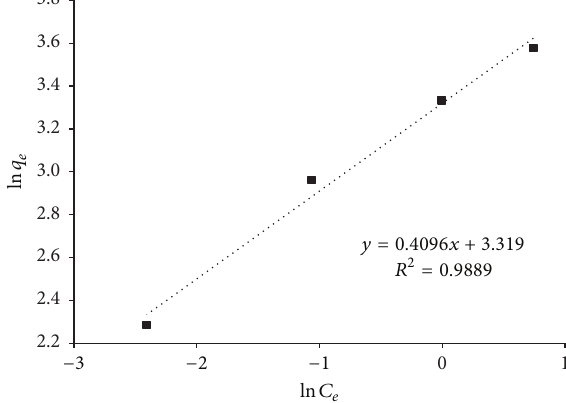
Figure 10: Freundlich isotherm (pH = 5.6, 𝐶 0 = 5–20 mg/L, dose = 0.5 g/L, contact time = 180 min, and temperature = 30 ∘